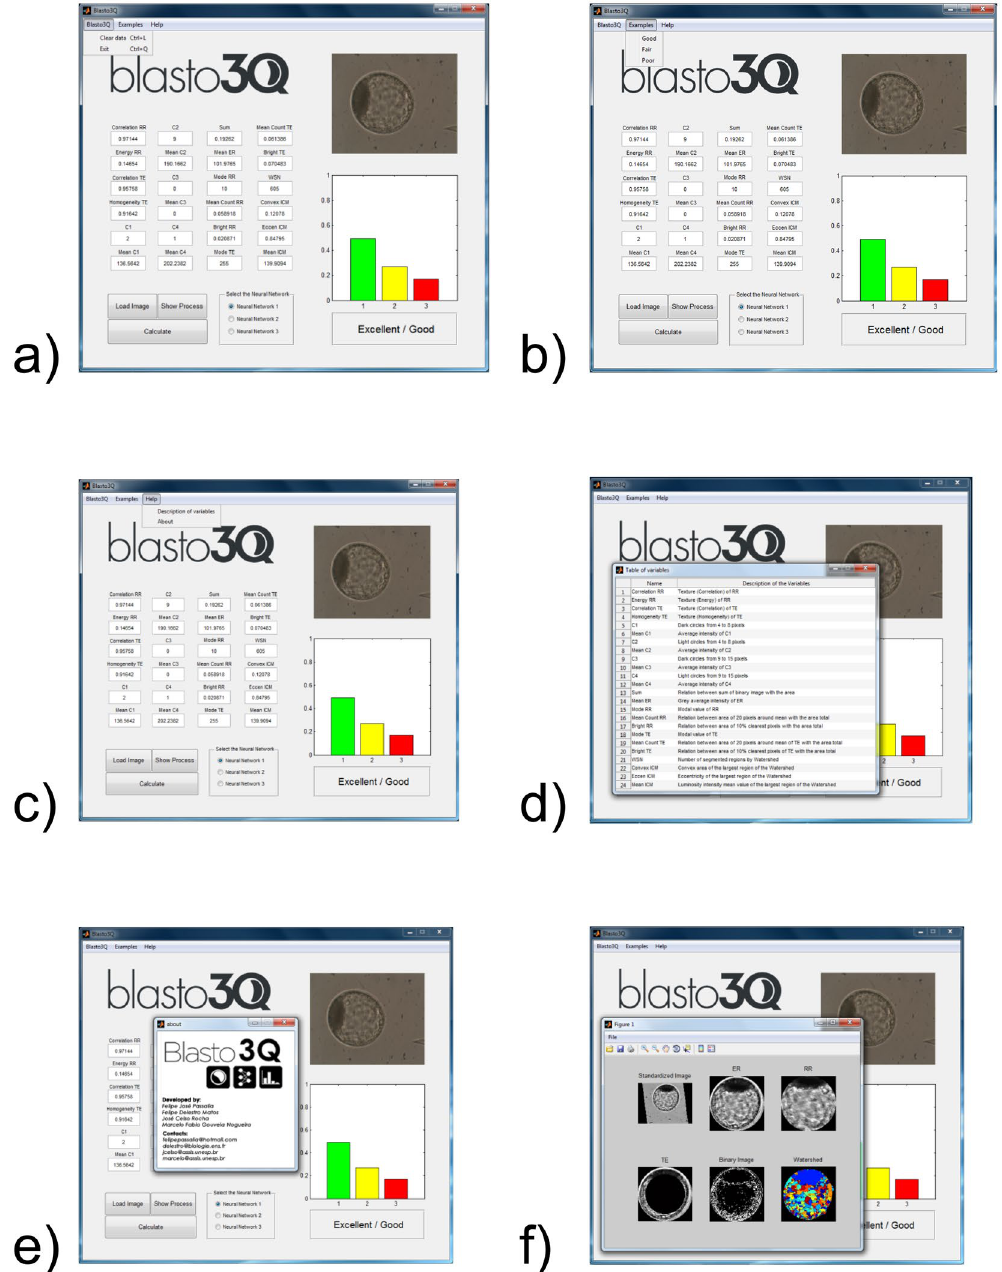
Figure 4. Tabs and buttons of the user-friendly interface. ( a ) Tab with options to clear the data or to close the interface; ( b ) tab with three images as standard models of excellent/good, fair, and poor; ( c ) tab with the variables and about the authors; ( d ) tab with the nominal description of the 24 variables; ( e ) tab with the authors’ details and e-mail correspondences; and ( f ) Standard, ER, RR, TE, Intersection and Watershed images of the selected